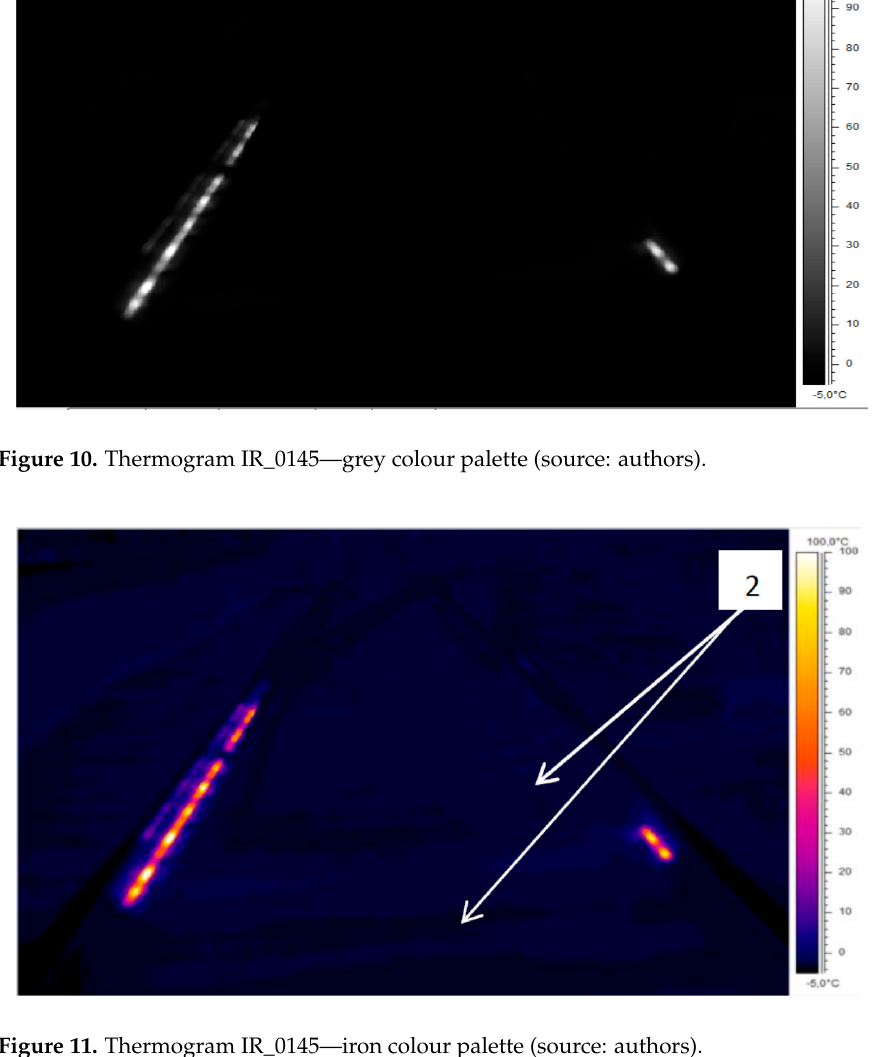
Figure 9. Thermogram IR_0145—rain900 colour palette (source: authors).